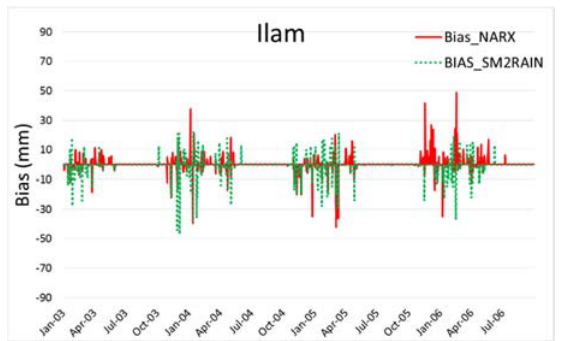
Figure 6. Bias (simulated ‐ observed) of the NARX ‐ and SM2RAIN ‐ modeled rainfall for the 5 KRB stations.